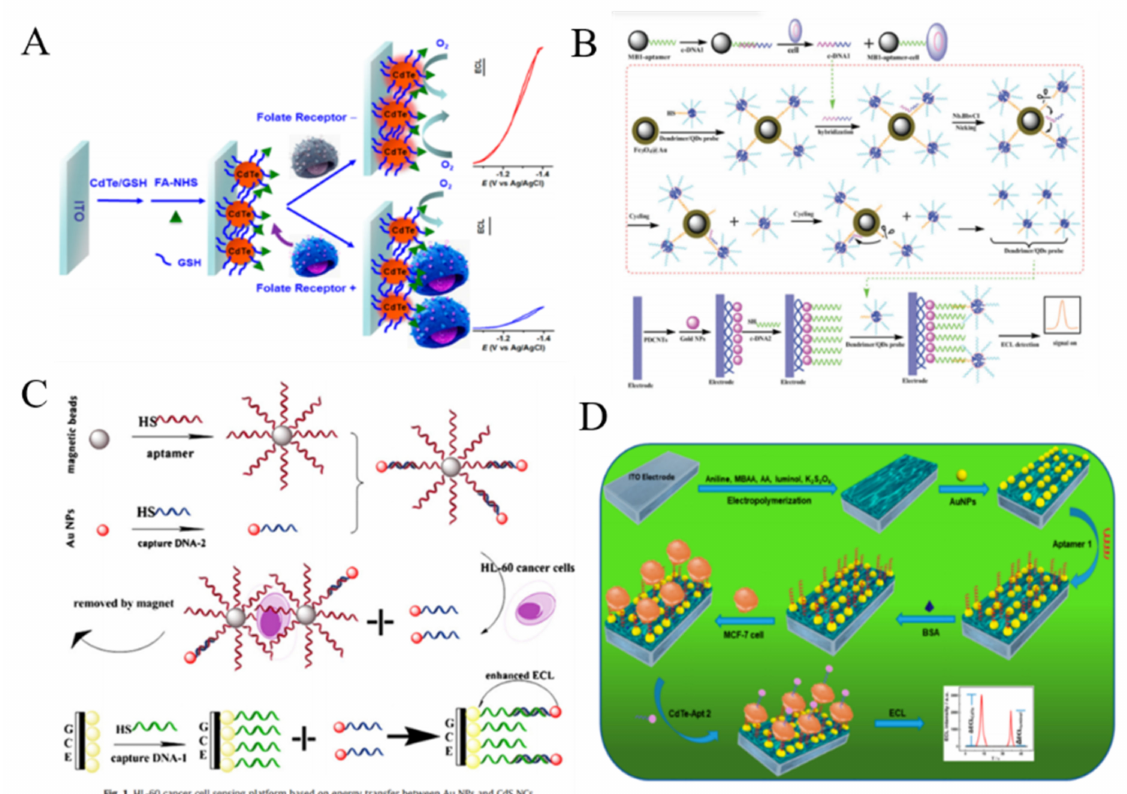
Figure 15. ( A ) Schematic representation of selective binding of FR (+) cells on FA functionalized CdTe/GSH NPs mod- ified ITO electrodes [241]. Copyright 2014 American Chemical Society. ( B ) Schematic representation of the dendrimer NCs/QDs-DNA probe and ECL biosensor for signal-off detection of cells [244]. Copyright 2011 American Chemical Society. ( C ) Schematic representation of HL-60 cancer cell sensing platform based on energy transfer between Au NPs and CdS QDs [250]. Copyright 2012 Elsevier B.V. ( D ) Schematic representation of the ratiometric ECL cytosensor based on conducting polymer hydrogel loaded with internal standard molecules [251]. Copyright 2019 American Chemical